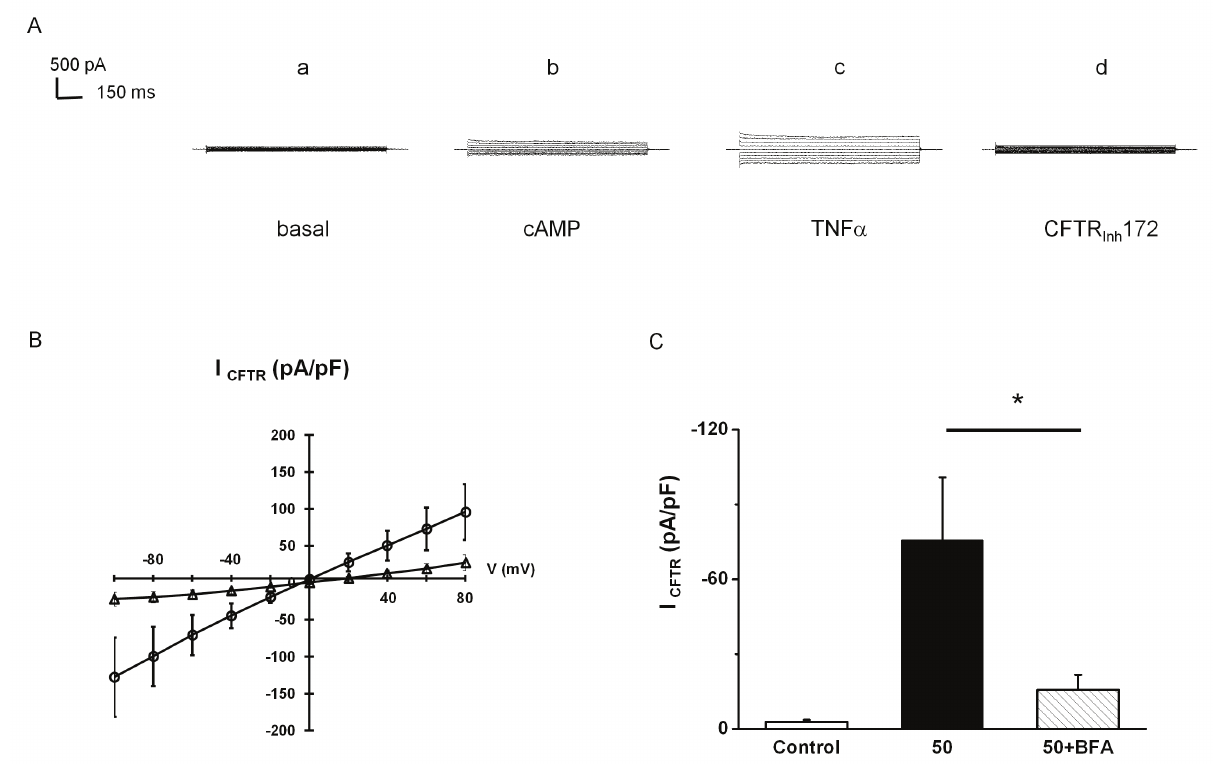
Figure 7. Stimulation of F508del-CFTR activity by 50 ng/ml TNF α is blocked by BFA. Whole cell Cl - currents recorded in HeLa cells expressing F508del-CFTR by patch-clamp experiments. * indicates significant results. A . Representative current traces recorded by holding the membrane potential at 0 mV and by pulsing the voltages in the range -100 mV to +80 mV at 20 mV steps for cells treated by 35 µM brefeldin A (BFA) for 2h. Current traces recorded: at the basal level ( a ); in the presence of CPT-cAMP/IBMX ( b ); in the presence of 50 TNF α +CPT- cAMP/IBMX ( c ); in the presence of CFTR 172+50 TNF α +CPT-cAMP/IBMX ( d ). B . Mean CFTR-related current-voltage relationships. Current Inh densities normalized to cell capacitance (pA/pF) were measured in the presence of TNF α ( O ); on cell treated for 2h by 35µM brefeldin A in the presence of TNF α ( ∆ ). C . Mean CFTR current amplitudes recorded at -60 mV and normalized to cell capacitance in untreated cells (control; mean + SEM; n=8), in cells treated for 10 minutes by TNF α (50; mean + SEM, n=8) and in cells treated by 35 µM brefeldin A for 2h and for